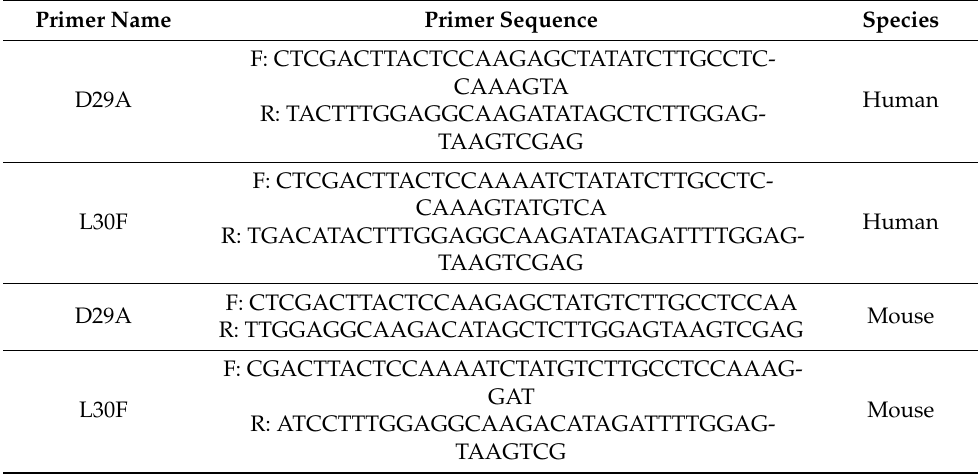
Table 2. Primer pairs used in our